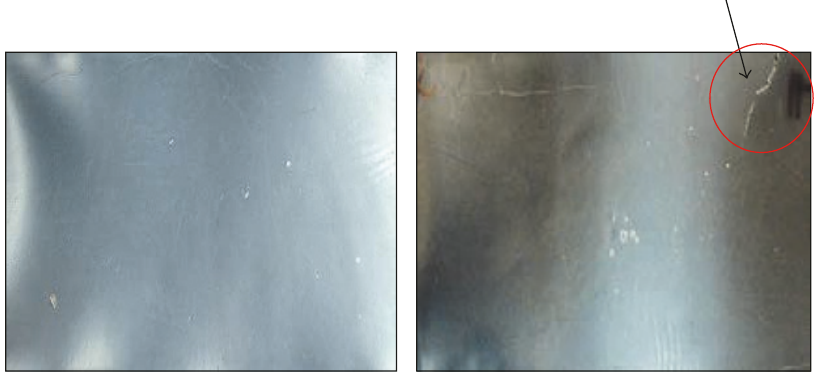
Figure 2: Oxo-degradable LDPE films at 0 and 330 hours of UV exposure in a Xenon arc